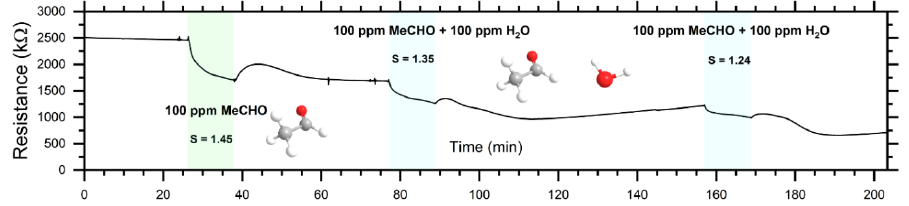
Figure 8. Responses of the ZnO-nanorods based chemiresistor to MeCHO and MeCHO / H 2 O vapours. The sequence of atmospheres was: reference air → 100 ppm MeCHO → reference air → 100 ppm